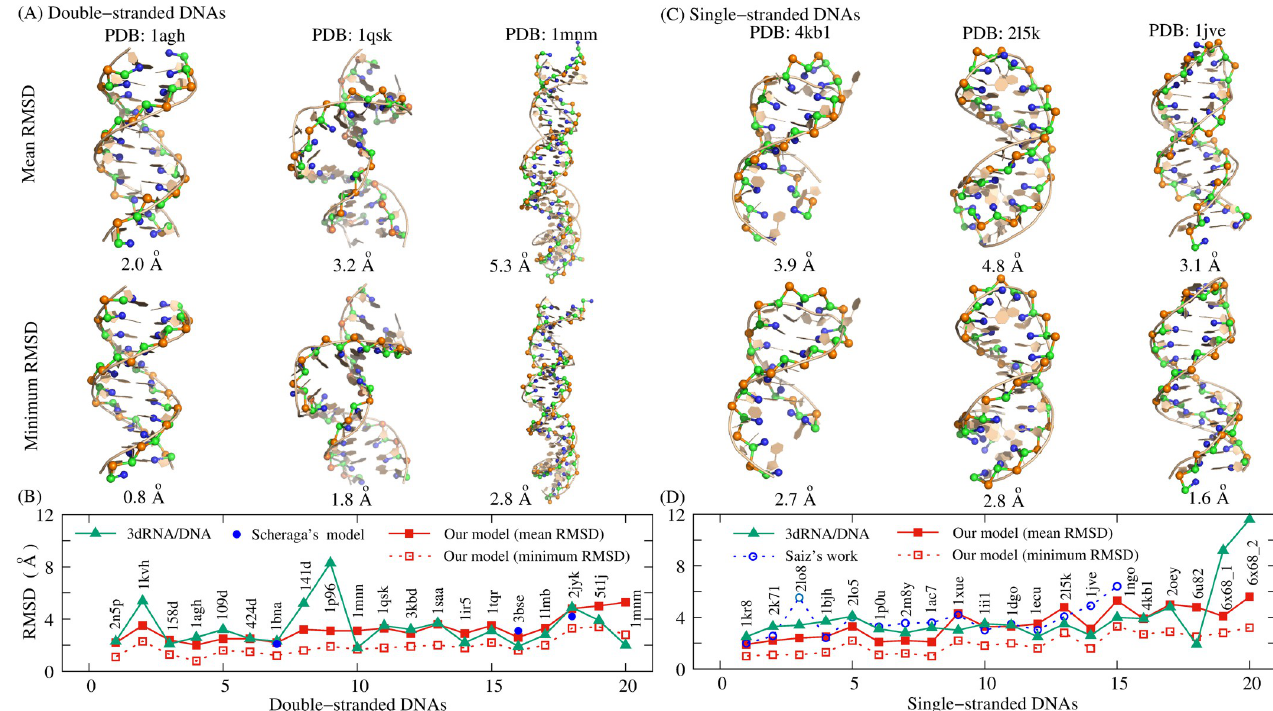
Fig 3. The display of typical predicted 3D structures, and comparisons of RMSDs between the present model and other models. (A,C) The predicted 3D structures (ball-stick) with the mean (top) and minimum (bottom) RMSDs for (A) three sample dsDNAs (PDBs: 1agh, 1qsk, and 1mnm) and (C) three ssDNAs (PDBs: 4kbl, 2l5k, and 1jve) from their native structures (cartoon). (B,D) The comparison of the predicted structures between the present model and the existing models including the 3dRNA/DNA and the models from Scheraga’s or Saiz’s group for (B) 20 dsDNAs and (D) 20 ssDNAs. The results of 3dRNA/ DNA are predicted through their online server based on the native secondary structures [53]. The other data is taken from refs. 56 and 59. The 3D structures are shown with PyMol (http://www.pymol.org).